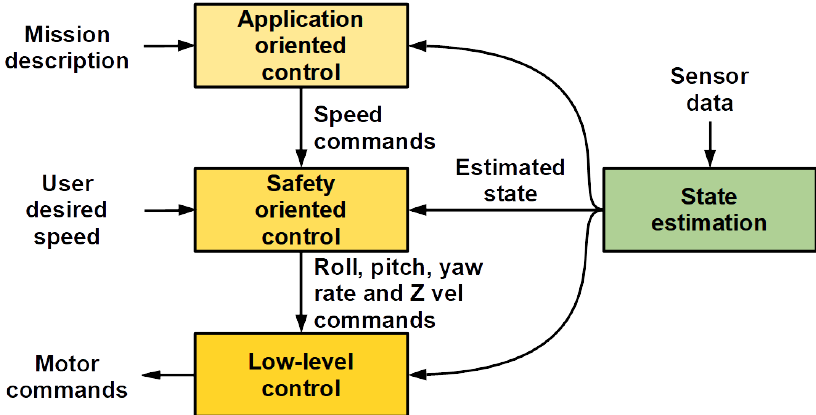
Figure 4. Control software of the aerial robot shown as a layered